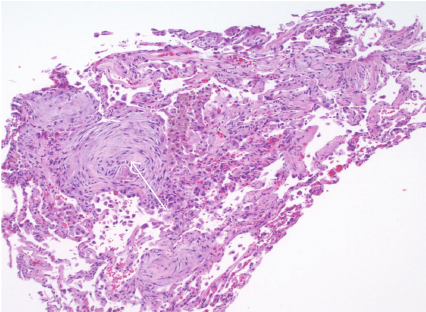
Figure 2: Transbronchial biopsy of the lung. Arrows point at myxoid fibroblastic plugs of bronchiolitis obliterans organizing pneumonia